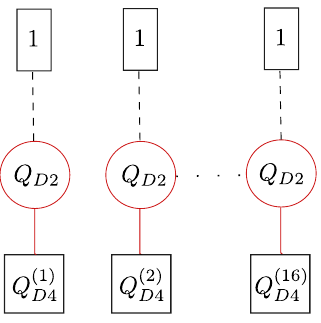
Figure 9 . Quiver associated to the AdS 3 × S 3 × T 4 solutions in Type